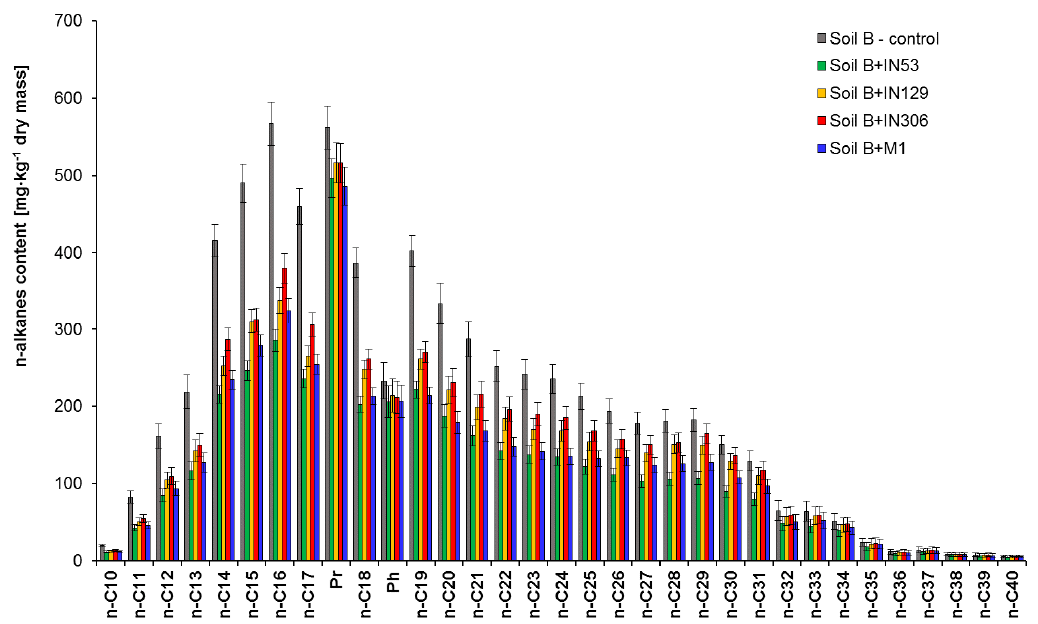
Figure 4. Residual n-alkanes content in sterile Soil B contaminated with TPH inoculated by Mycolicibacterium frederiksbergense IN53, Rhodococcus erythropolis IN129, Rhodococcus sp. IN306 and mixed culture M1 after a 30-day biodegradation process, (repetition number n = 8–10, p < 0.05). Control non-inoculated Soil B.